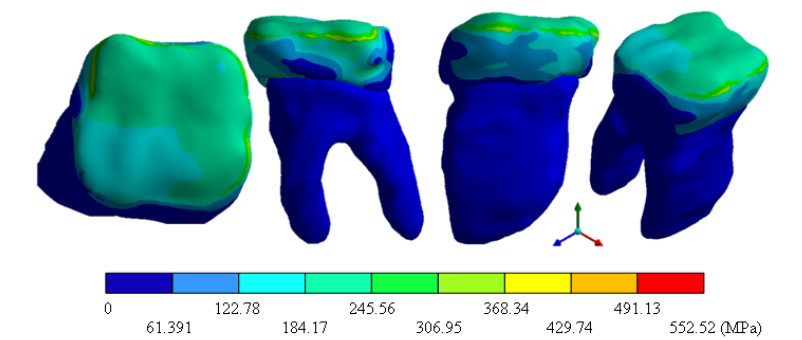
Figure 10. Von Mises stress for